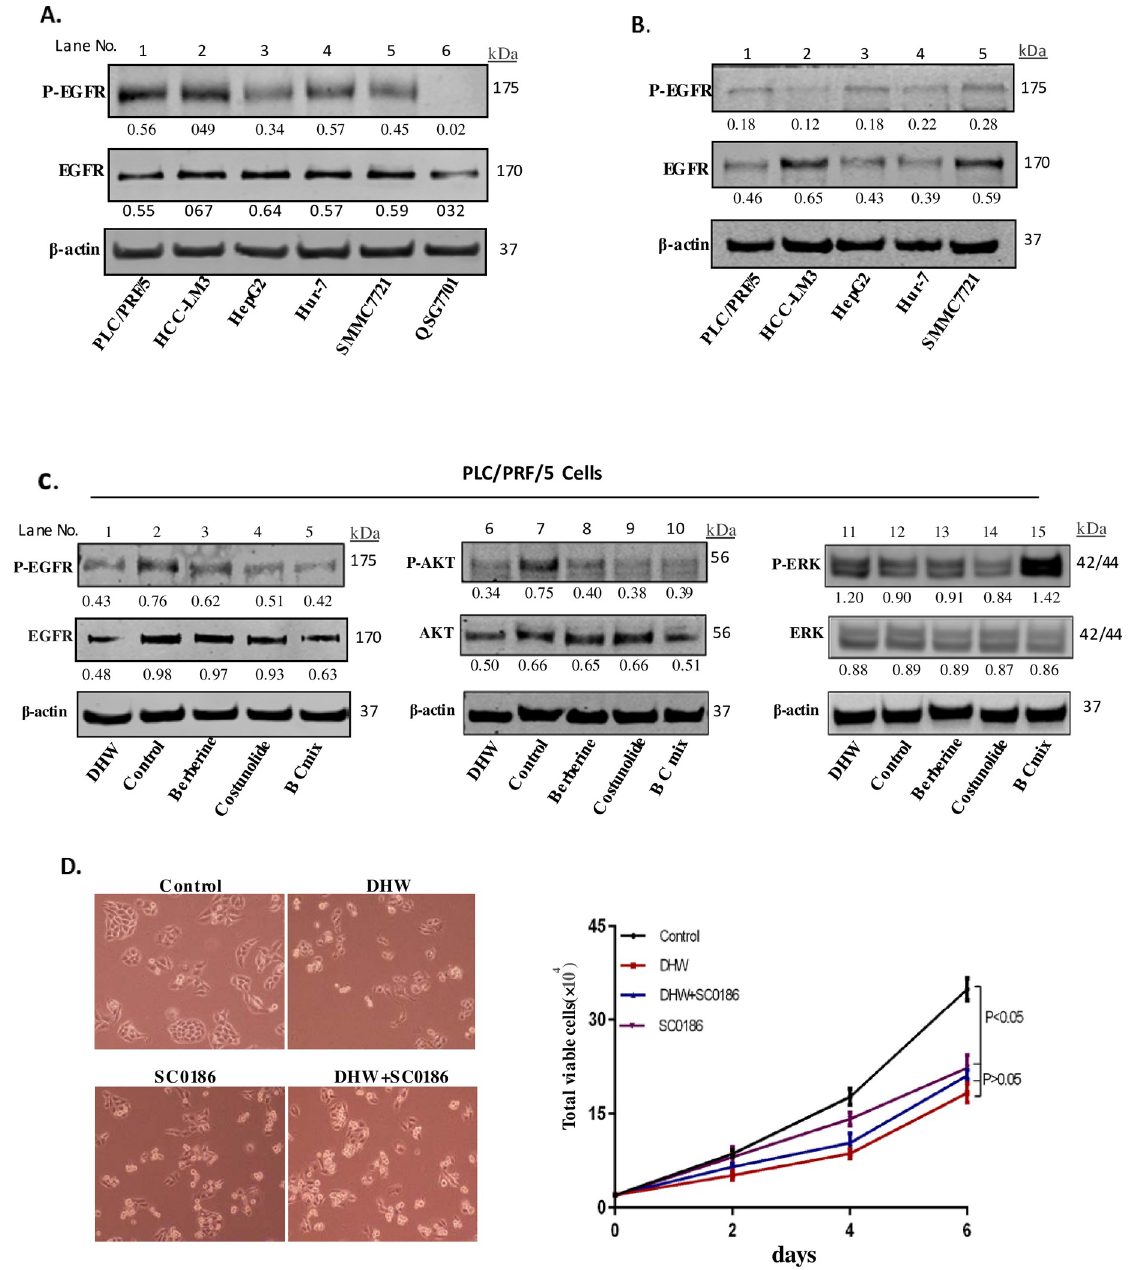
Fig 3. A, the expression and activation of EGFR in hepatoma cells such as PLC/PRF/5, HCC-LM3, HepG2, Hur7 and SMMC-7721 cells compared to normal hepatocytes; B, The EGFR and P-EGFR levels in HCC cells were examined by Western blot after treatment treated